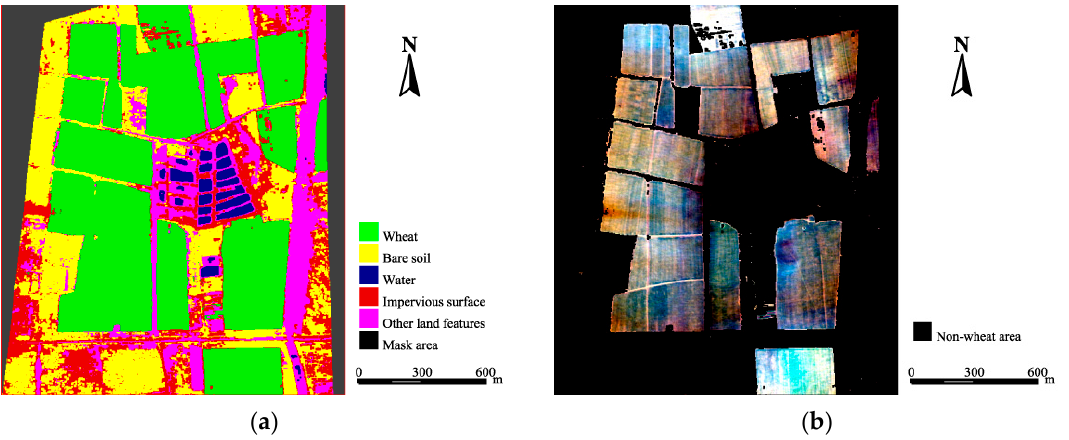
Figure 5. Hyperspectral image classification result ( a ) and wheat cover area extraction result ( b ).